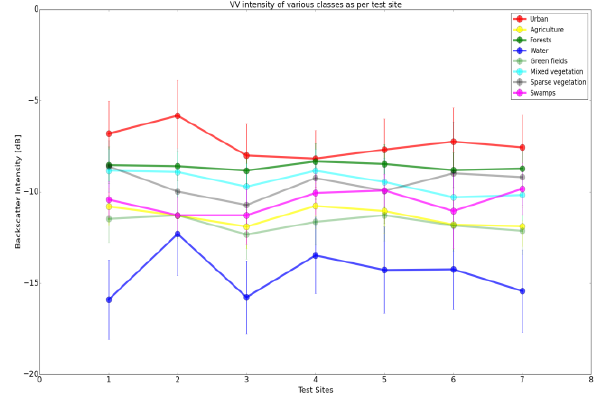
Figure 4. Trend of SAR backscatter intensities of pixels belonging to each LBM-DE2012 land cover class with respect to the test site analysed. The colours represent the 8 LBM-DE2012 land cover themes shown in the legend